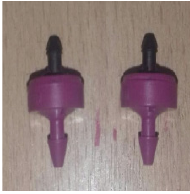
Figure 4. NETAFIM self-compensating